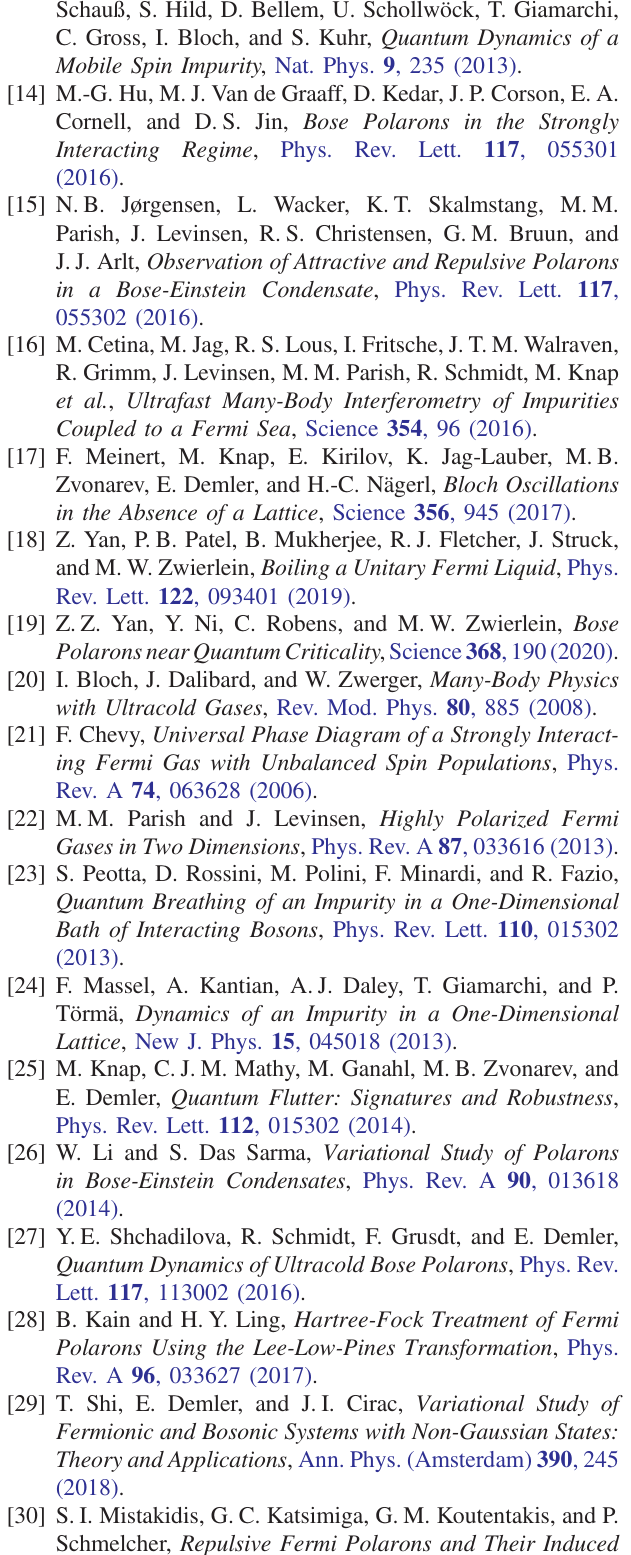
as a function of frequency ω and F